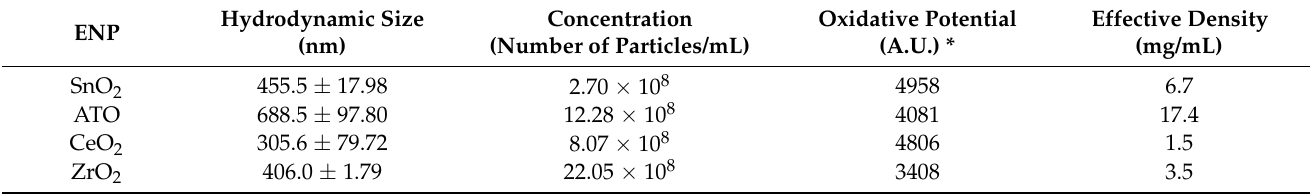
Table 1. Physicochemical characteristics of the tested engineered nanoparticles (ENP) stock suspensions. Hydrodynamic Size Concentration Oxidative Potential Effective Density ENP (nm) (Number of Particles/mL) (A.U.) * (mg/mL) SnO 2 455.5 ± 17.98 ATO 688.5 ± 97.80 CeO 2 305.6 ± 79.72 Data are presented as mean ± SD. Hydrodynamic size was measured by Dynamic Light Scattering (DLS). Concentration was determined by Nanoparticle Tracking Analysis (NTA). Oxidative potential was measured by Electronic Spin Resonance (ERS). A.U.: arbitrary units. * Negative control (ultrapure water) = 3191 A.U.; Positive control (DOFA) = 48,041